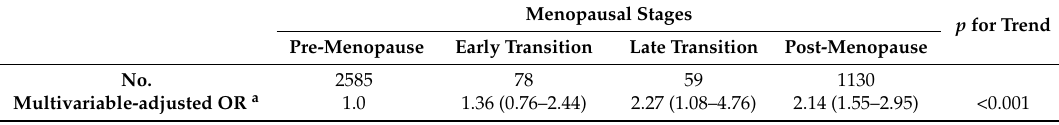
Table 3. Age-matched conditional logistic analysis of hyperuricemia by menopausal stage ( n = 3356).